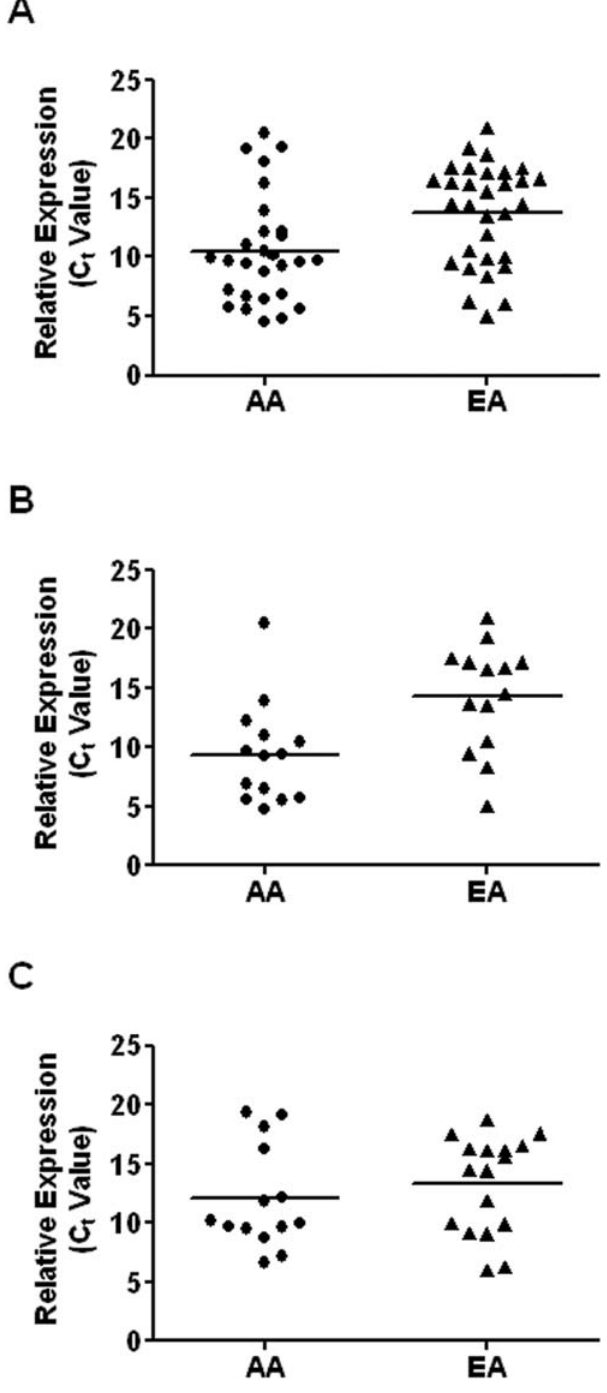
Figure 4. Differences in tumor HLA-DQ mRNA expression between African-American (AA) and European-American (EA) breast cancer patients. qRT-PCR analysis of HLA-DQ expression in extracts from 59 fresh-frozen breast tumors. (A) Relative HLA-DQ expression comparing AA patients (n=28) with EA patients (n=31) across all tumors. The expression of HLA-DQ is significantly higher in AA than EA patients ( P =0.007; t-test). (B) Relative HLA-DQ expression in ER- negative tumors comparing AA patients (n=14) with EA patients (n=14). The expression of HLA-DQ is significantly higher in AA than EA patients (average fold difference: 29.6; P =0.006; t-test). (C) Relative HLA-DQ expression in ER-positive tumors comparing AA patients (n=14) with EA patients (n=17). The expression of HLA-D mRNA in ER-positive tumors was not significantly different between AA and EA patients ( P =0.42; t- test). Note: C t values are inversely correlated to mRNA expression.